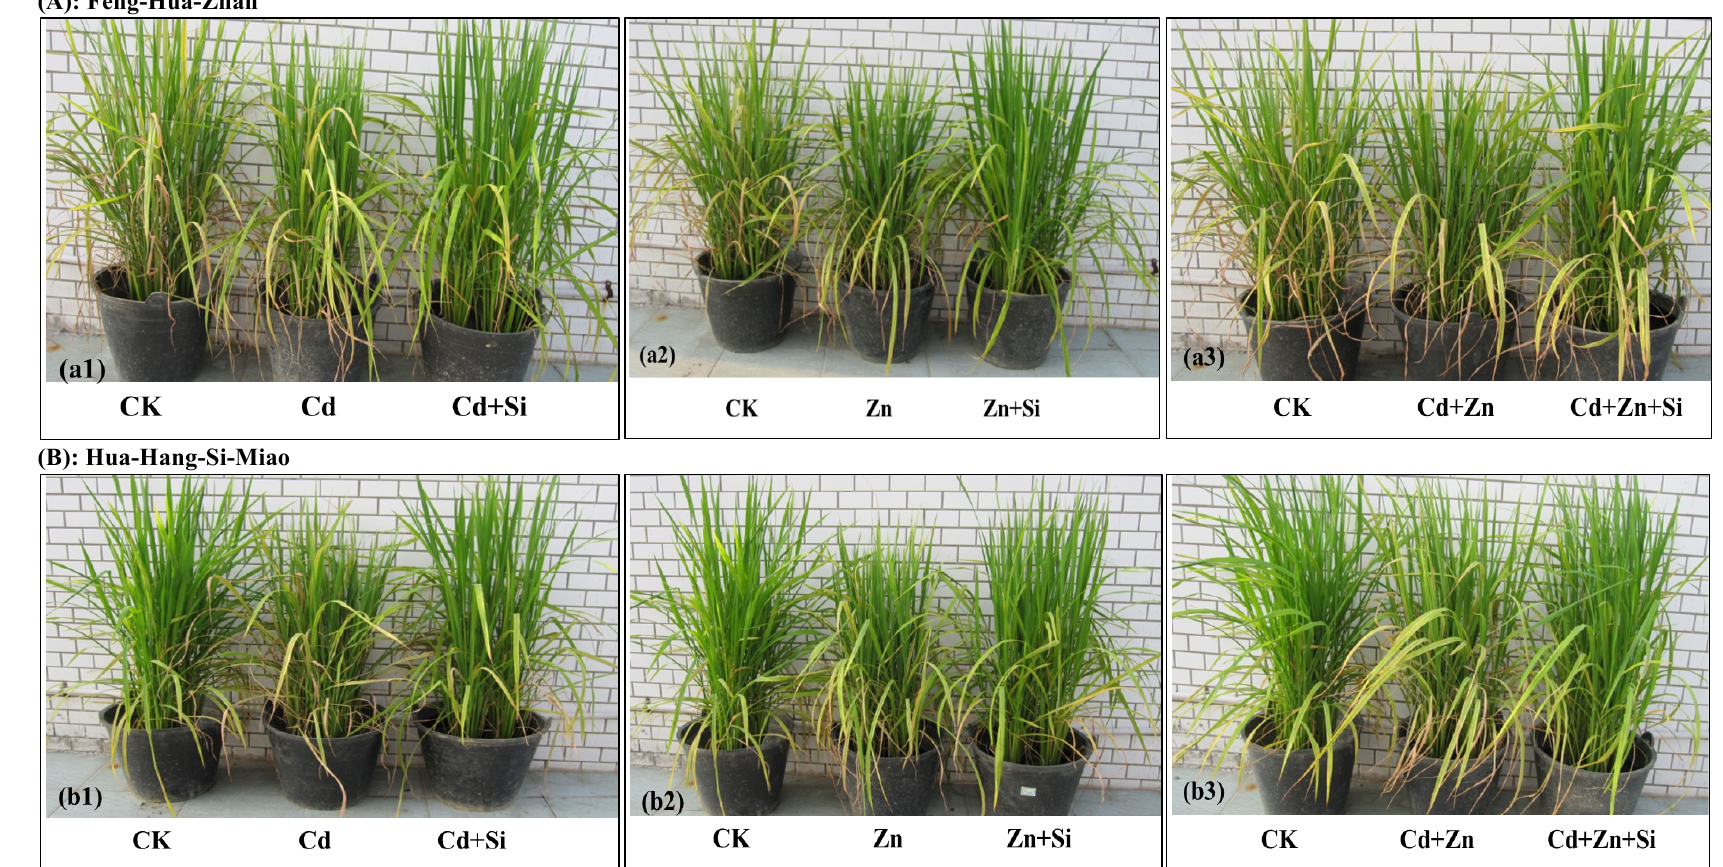
Figure 1. Mitigation of Si on growth inhibition in two rice cultivars under Cd and excess Zn stress at the tillering stage: ( a1 ) and ( b1 ) Cd stress; ( a2 ) and ( b2 ) Zn stress; Figure+1. "Mitigation"of"Si"on"growth"inhibition"in"two"rice"cultivars"under"Cd"and"excess"Zn"stress"at"the"tillering"stage:"( a1 )"and"( b1 )"Cd"stress;"( a2 )"and"( b2 )"Zn"stress;"( a3 )"and"( b3 )"Cd"+" Zn"stress." ( a3 ) and ( b3 ) Cd + Zn